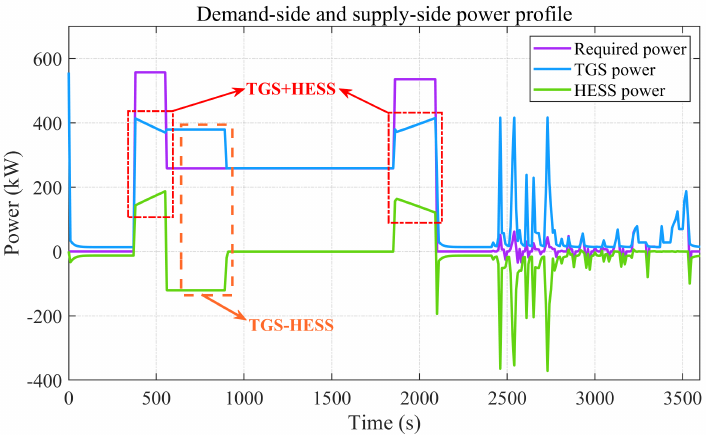
Figure 13. Demand-side and supply-side power profiles of the TEHPS.